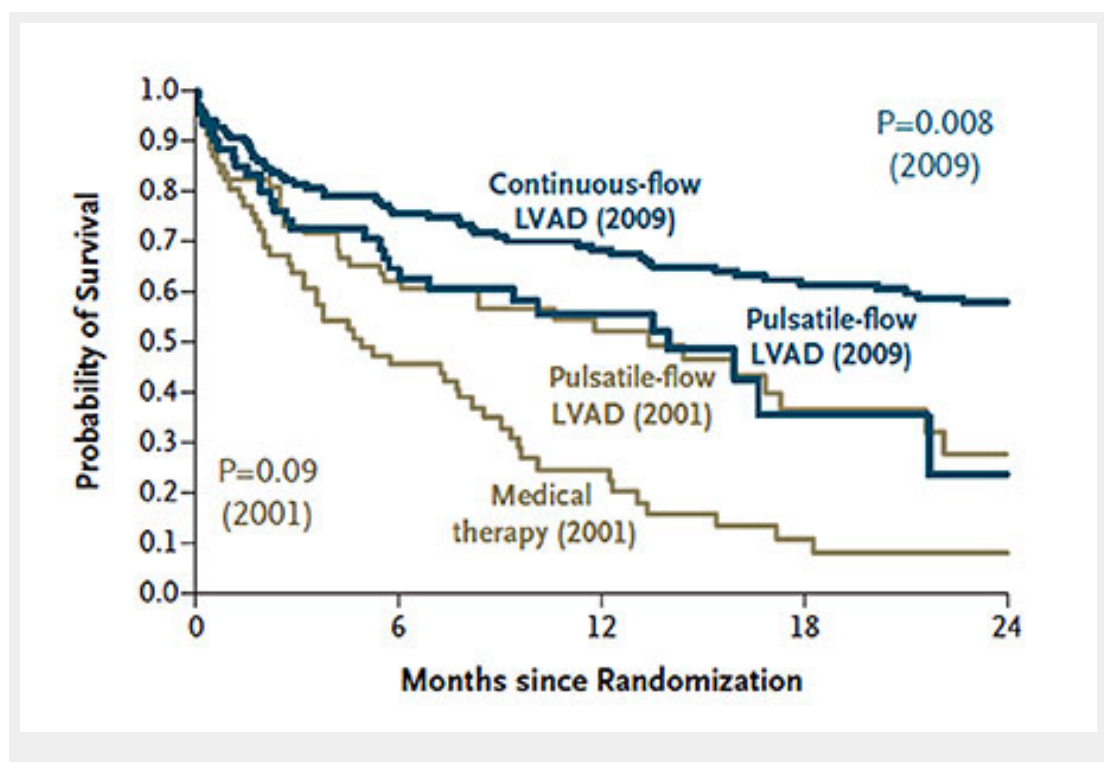
Figure 2 Survival rates in two trials of LVADs as destination therapy (REMATCH trial 2001, HeartMate II destination therapy trial 2009). © 2009 Massachusetts Medical Society. Fang JC. Rise of the machines – left ventricular assist devices as permanent therapy for advanced heart failure. N Engl J Med 2009;361:2282-85 [12]. Reprinted with kind